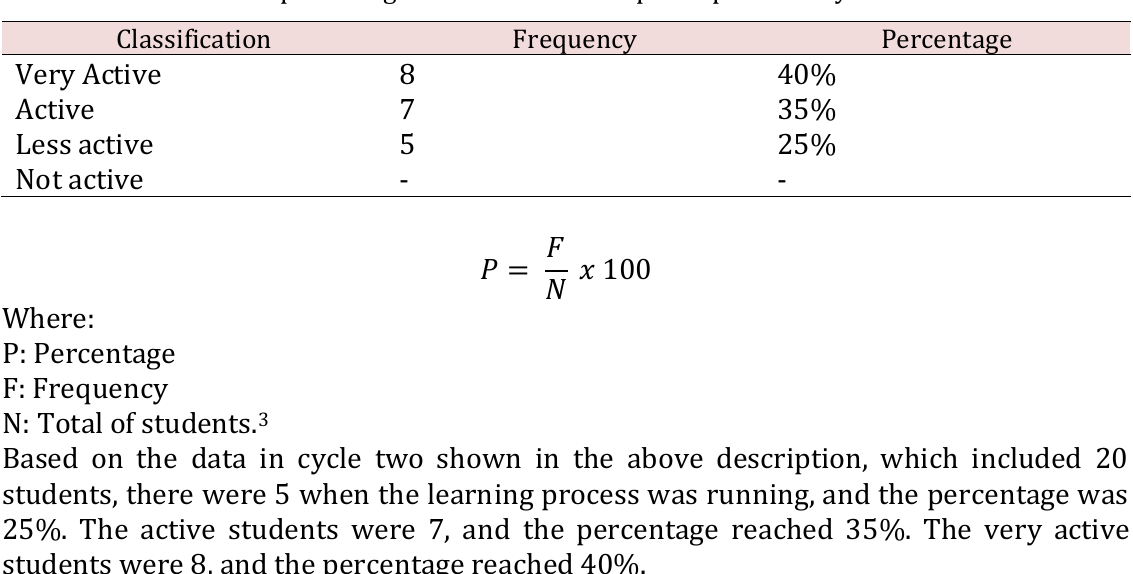
The percentage of students' active participation in cycle